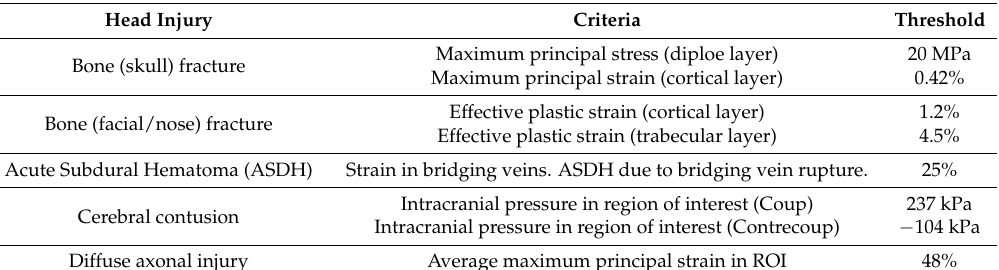
Table 3. Head injury criteria, adapted from